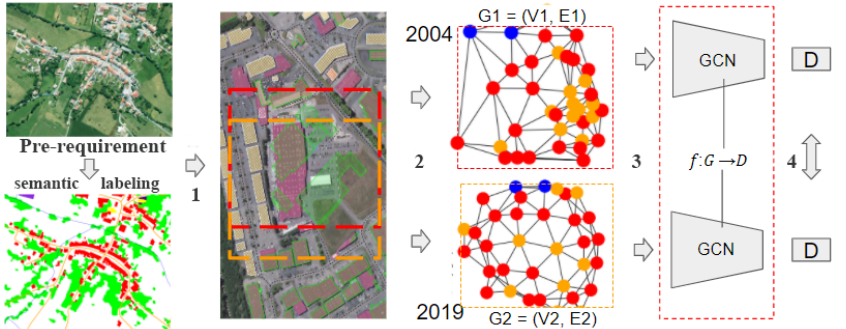
Figure 1. The proposed approach GisGCN consists of several steps: (1) selection of the POI and surrounding geographical zones for cross-time data; (2) for each geographic zone, representation of its geographic entities as a connected labelled graph; (3) for each graph, GCN-based embedding learning with shared weights; (4) similarity-based retrieval of geographic areas across